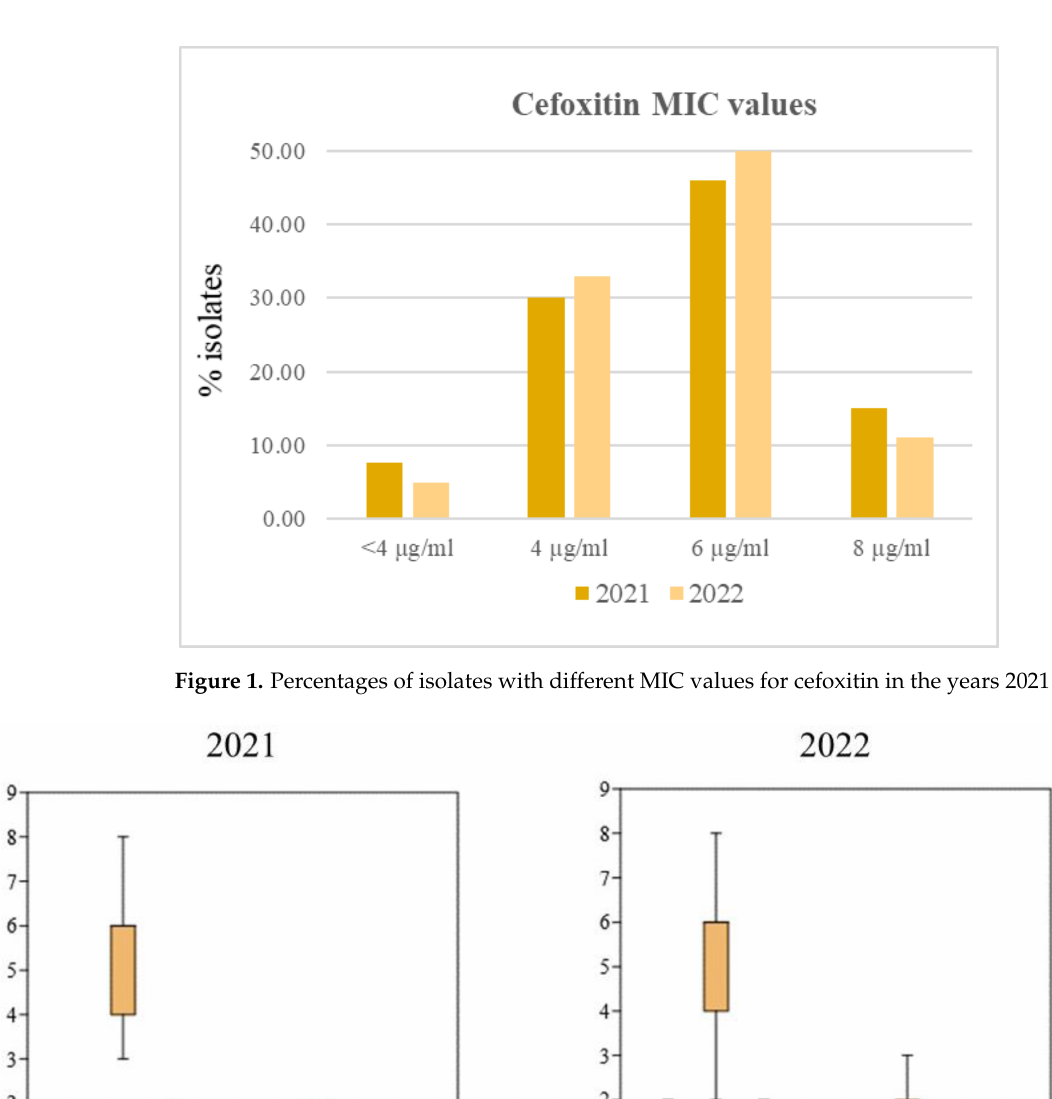
Figure 2. Distribution of MIC values for oxacillin (OXA), cefoxitin (FOX), norfloxacin (NOR), eryth- romycin (ERY), gentamicin (CN), kanamycin (KAN), tobramycin (TOB) and clindamycin (CD) in the years 2021 and 2022.